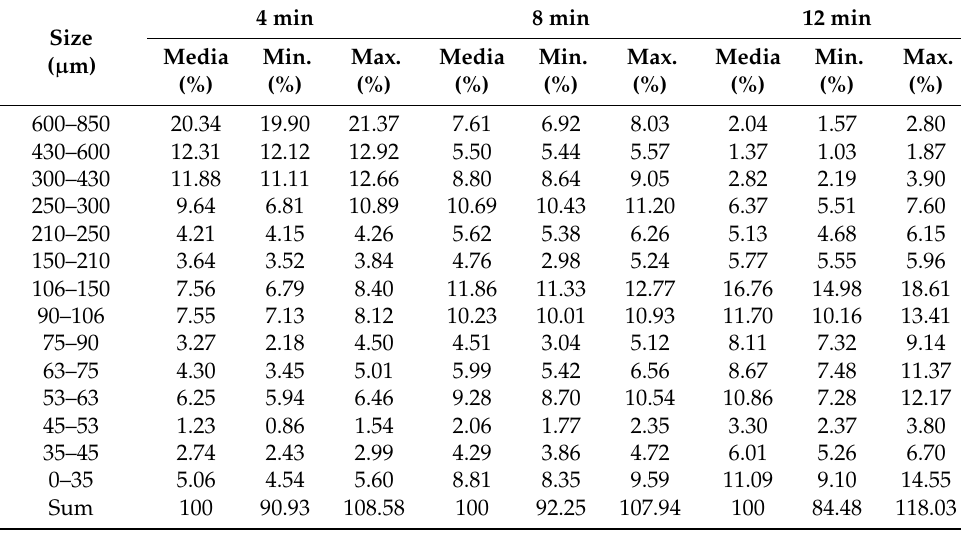
Table 2. PSCP of the feed under different grinding